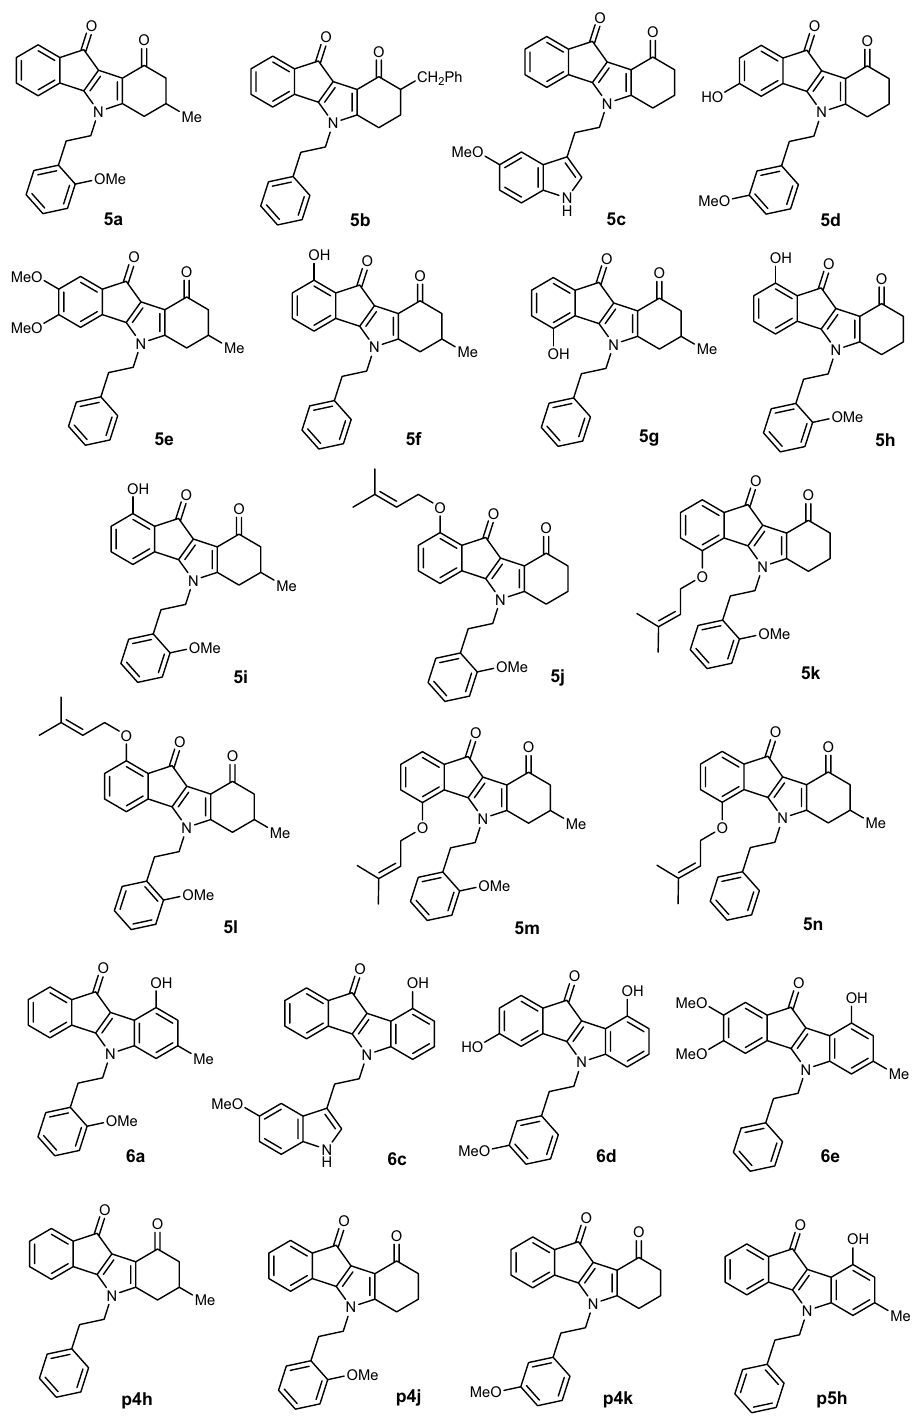
Figure 1. Structures of all studied ketonic and phenolic indeno[1,2- b ]indole derivatives (compounds p4h , p4j , p4k and p5h were already published 19, 20